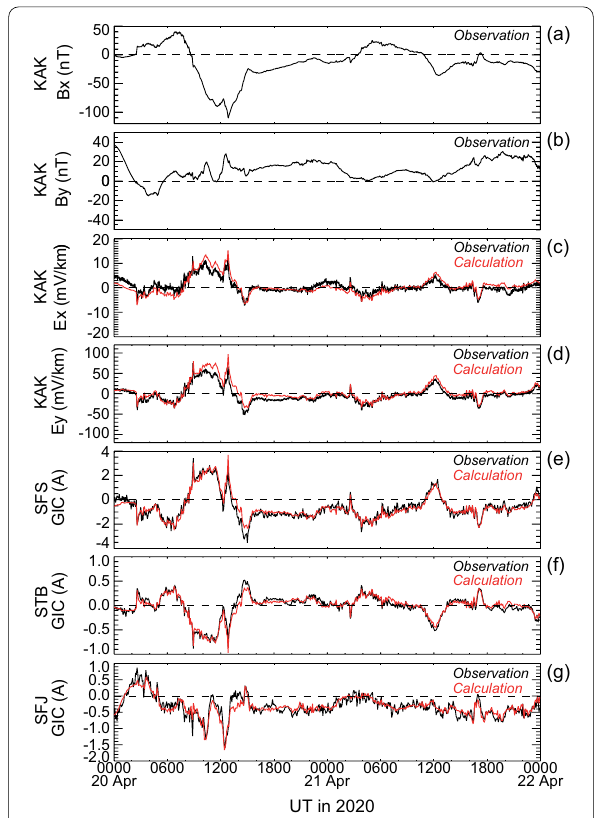
Fig. 2 a , b Geomagnetic disturbances B x and B y at Kakioka; c , d geoelectric disturbances E x and E y at Kakioka; e GIC at the substation SFS; f GIC at the substation STB, and g GIC at the substation SFJ. The black lines indicate the observed values, and the red lines indicate the calculated